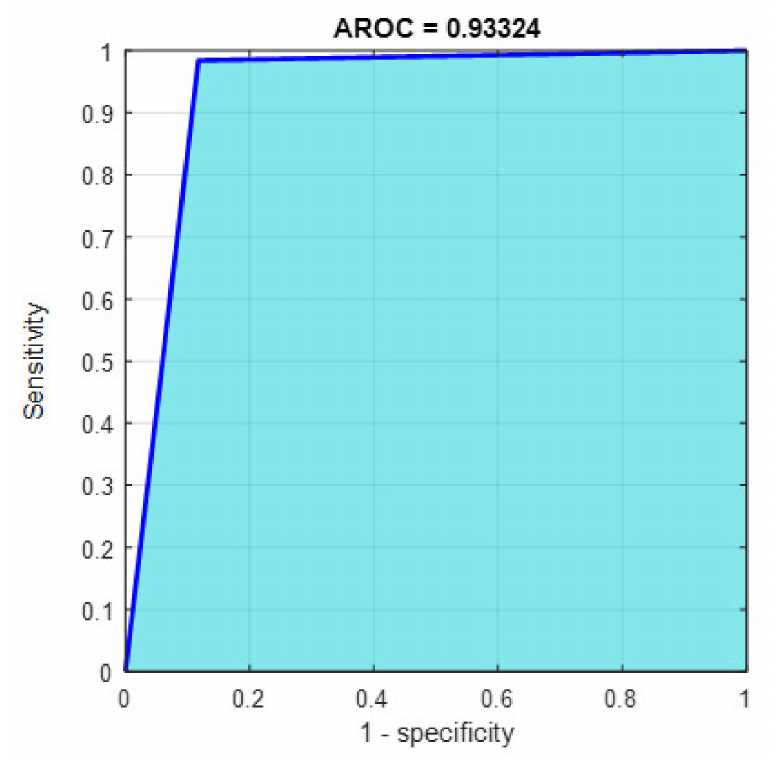
Figure 24. The AROC for Model 2 using 1000 deep learning